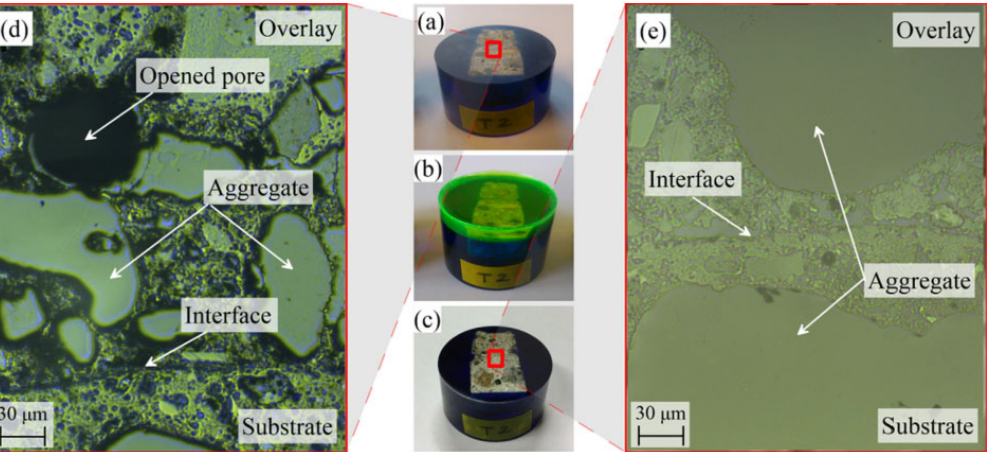
Figure 13. Optical microscopy view of the surface of concrete specimens to be repair. Samples: ( a ) after preliminary grinding (open pores appeared); ( b ) after the second immersion in epoxy resin in a vacuum chamber; ( c ) after final grinding and polishing. The optical microscopy view of the surface: ( d ) after preliminary grinding; ( e ) after final grinding and polishing [73]. (Adapted and reprinted with permission from ref. [73], © 2019, Construction and Building Materials ).